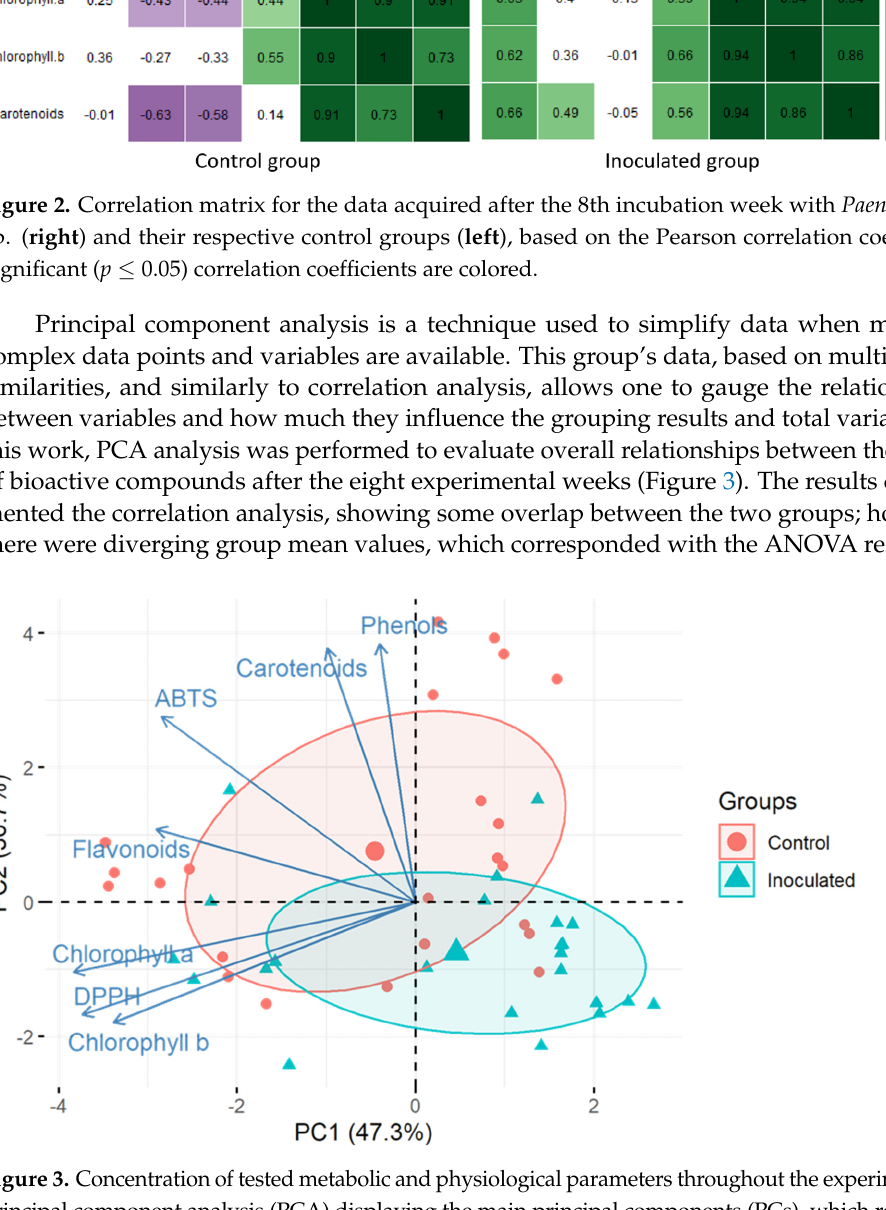
92.3% of the total variance of the parameters (Table 1). Table 1. Total variance of the cumulative data gathered throughout the experiment explained by principal components.